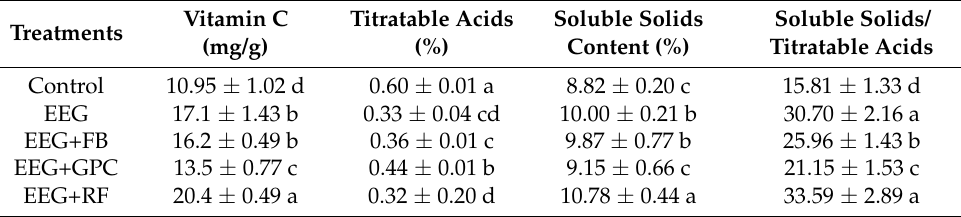
Table 2. Effects of foliar spraying easily extractable glomalin-related soil protein in combination with agronomic strategies on the internal quality of fruits in Satsuma mandarin “Oita 4”. Vitamin C Titratable Acids Soluble Solids Soluble Solids/ Treatments (mg/g) (%) Content (%) Titratable Acids Control 10.95 ± 1.02 d